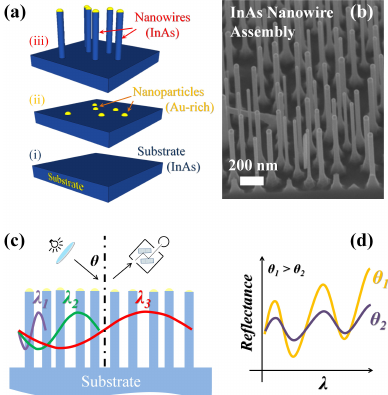
Figure 1. ( a ) Schematics of a set of samples used in this work: (i) the InAs substrate; (ii) the InAs substrate with dispersed Au-rich catalyst nanoparticles; (iii) the InAs substrate with the InAs nanowire (NW) assembly; ( b ) ≈ 45 ◦ tilted scanning electron micrograph of InAs NWs (density ≈ 30 NW/ µ m 2 , diameter ≈ 50 nm, length ≈ 950 nm); ( c ) as light impinges on the NW assembly, photons with a short wavelength interact with few individual NWs, while large wavelengths see the whole assembly as an effective-medium; ( d ) diffraction and interference effects give rise to reflectance oscillations versus photon wavelength and incidence